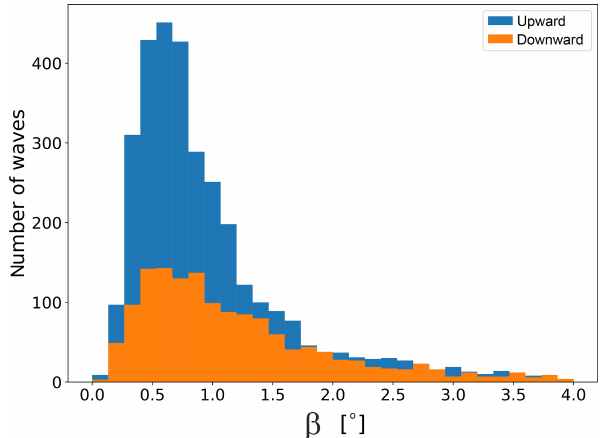
Figure 16. Histogram of the absolute value of the angle between the group velocity vector and the horizon, separated for upward- and downward-propagating waves.